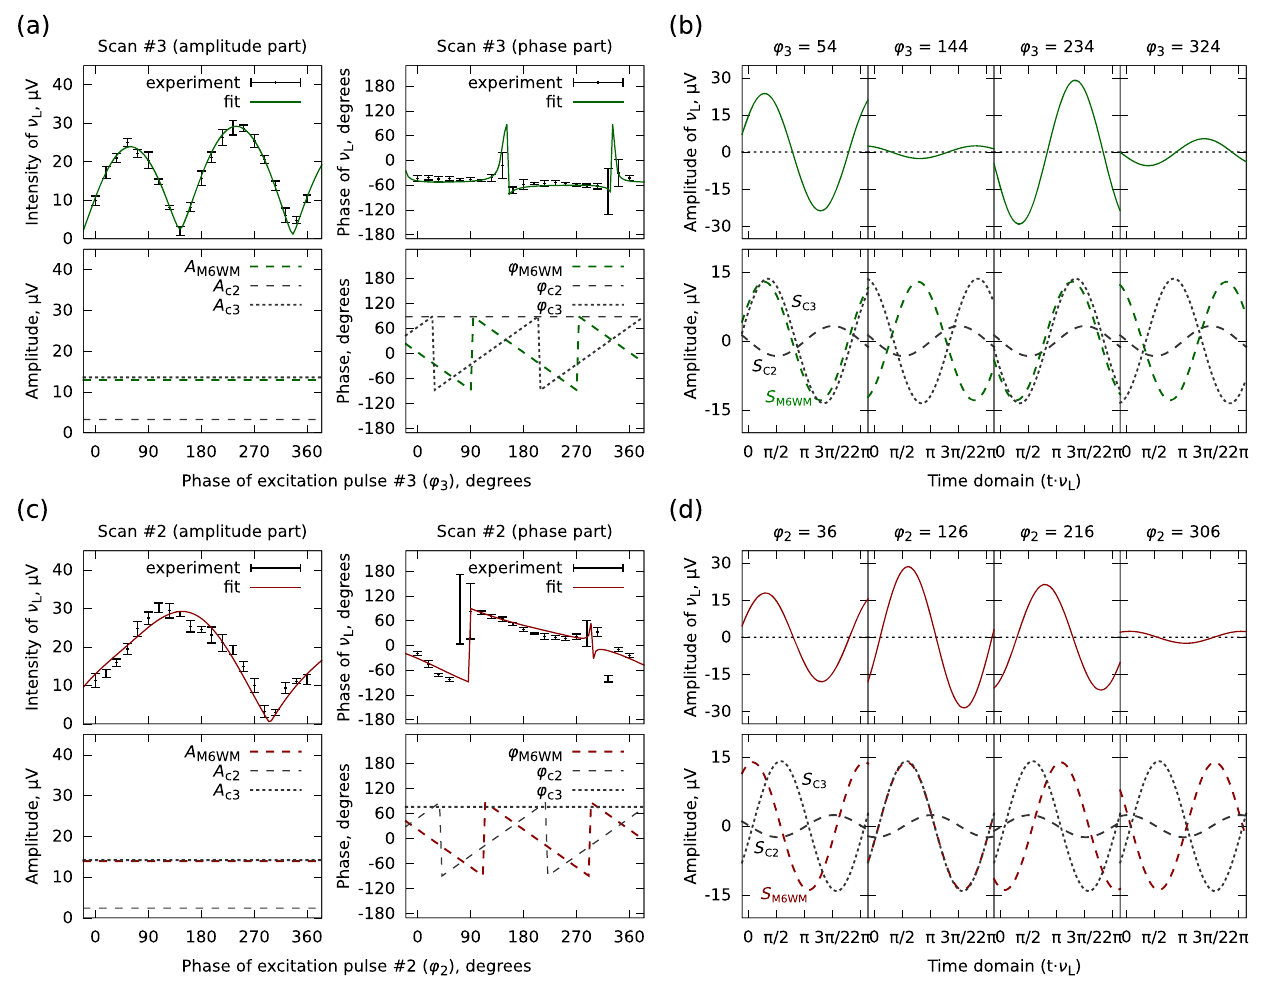
Fig. 4 | Illustration of the interference patterns. Left: experimentally observed interference patterns and the simulations based on the least-squares fi ts, when scanning the phase of pulse #3 ( a ) and pulse #2 ( c ). The upper traces show the experimental results together with the overall fi t with regard to the intensity and phase at the frequency of the listen transition ν L , respectively. The errors are cal- culated from a set of fi ve repeated measurements, as mentioned for Fig. 3. The amplitudes and phases of the individual interfering wave components are pre- sentedinthelowertraces.Ineachsubplotofthephasepart,thephaseonthey-axis